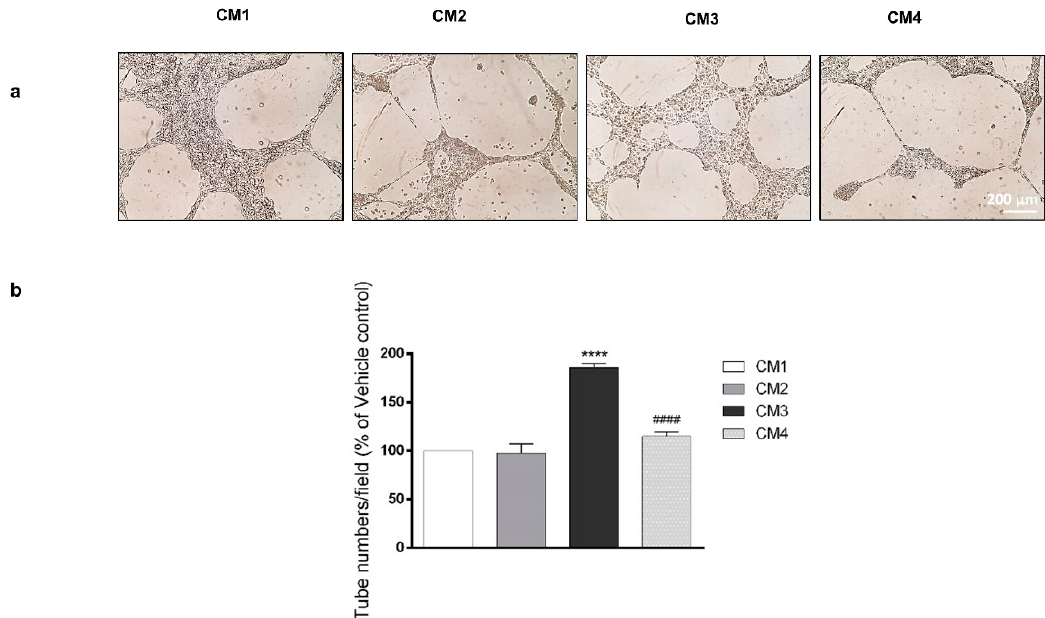
Figure 4. Effect of PACAP on new vessels formation. ( a ) Representative results of tube formation assay. H5V cells were cultured with 200 µ L of conditioned medium derived from U87MG cells treated with vehicle (CM1), PACAP (CM2), DFX (CM3) or DFX plus PACAP (CM4). The tubes were visualized under a microscope for quantification and calculated as the average tube numbers per field in duplicate for each well. ( b ) In the bar graph, values are expressed as percentage of control (**** p < 0.0001 vs. CTRL; #### p < 0.0001 vs. DFX).